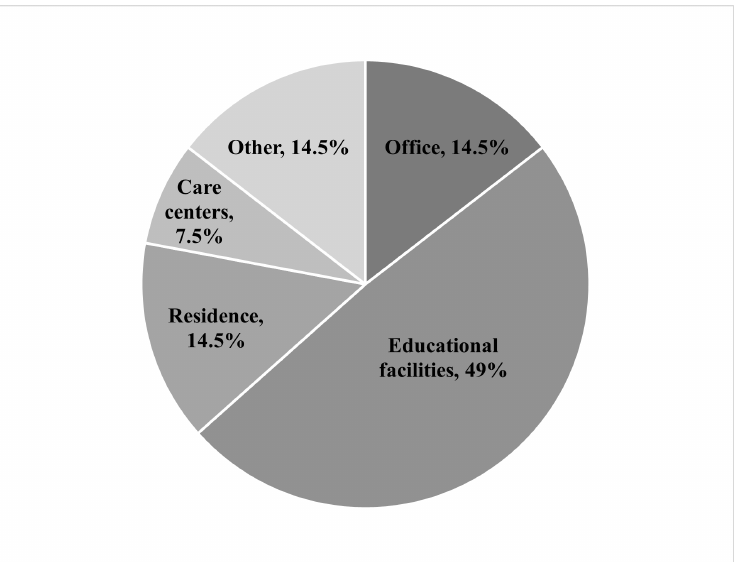
Figure 5. Building type statistics for the selected field measurement